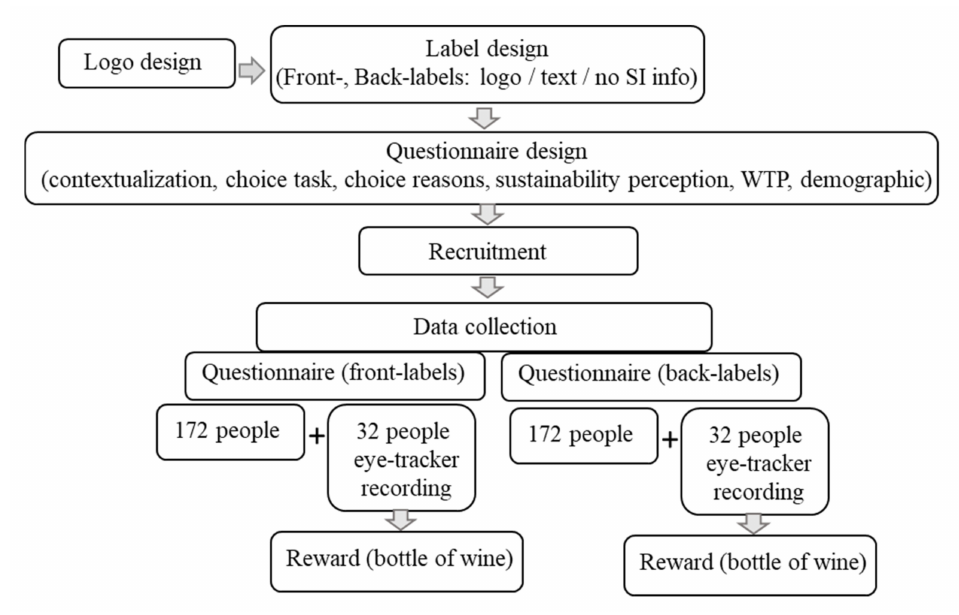
Figure 1. Overview of the experiment design.